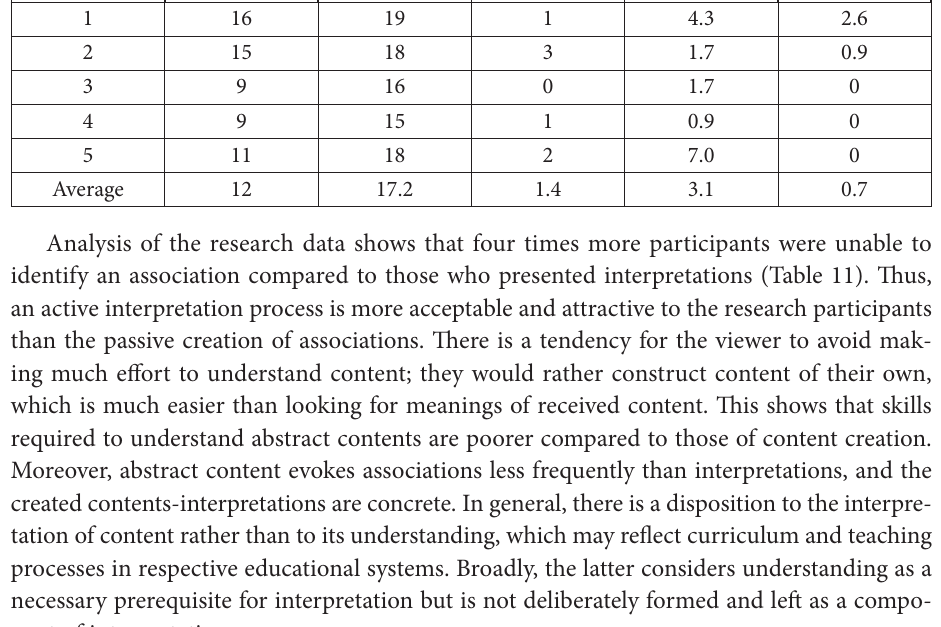
a s t o f n t m e g a F r